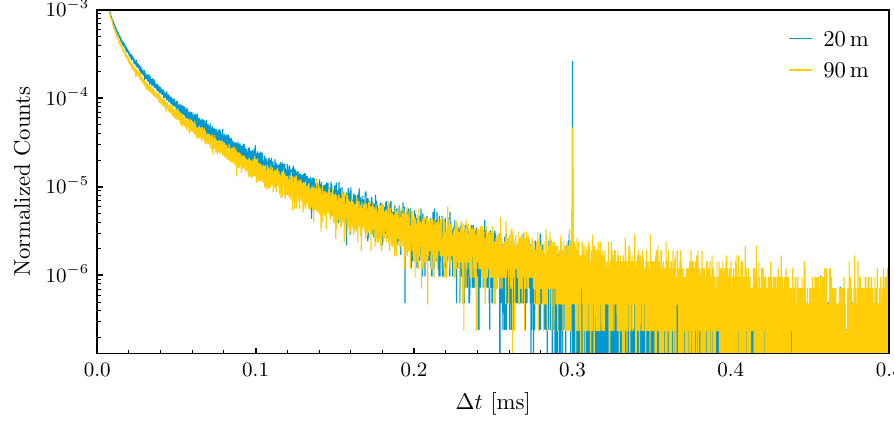
Figure 2. Time-di ff erence histogram of subsequent pulses recorded by two sDOMs in STRAW with distances of 20 and 90m to the flashing POCAM using 465nm LED pulses. A clear signal at the flashing frequency of 3kHz confirms the detection over the full distance range of the STRAW detector. Adapted